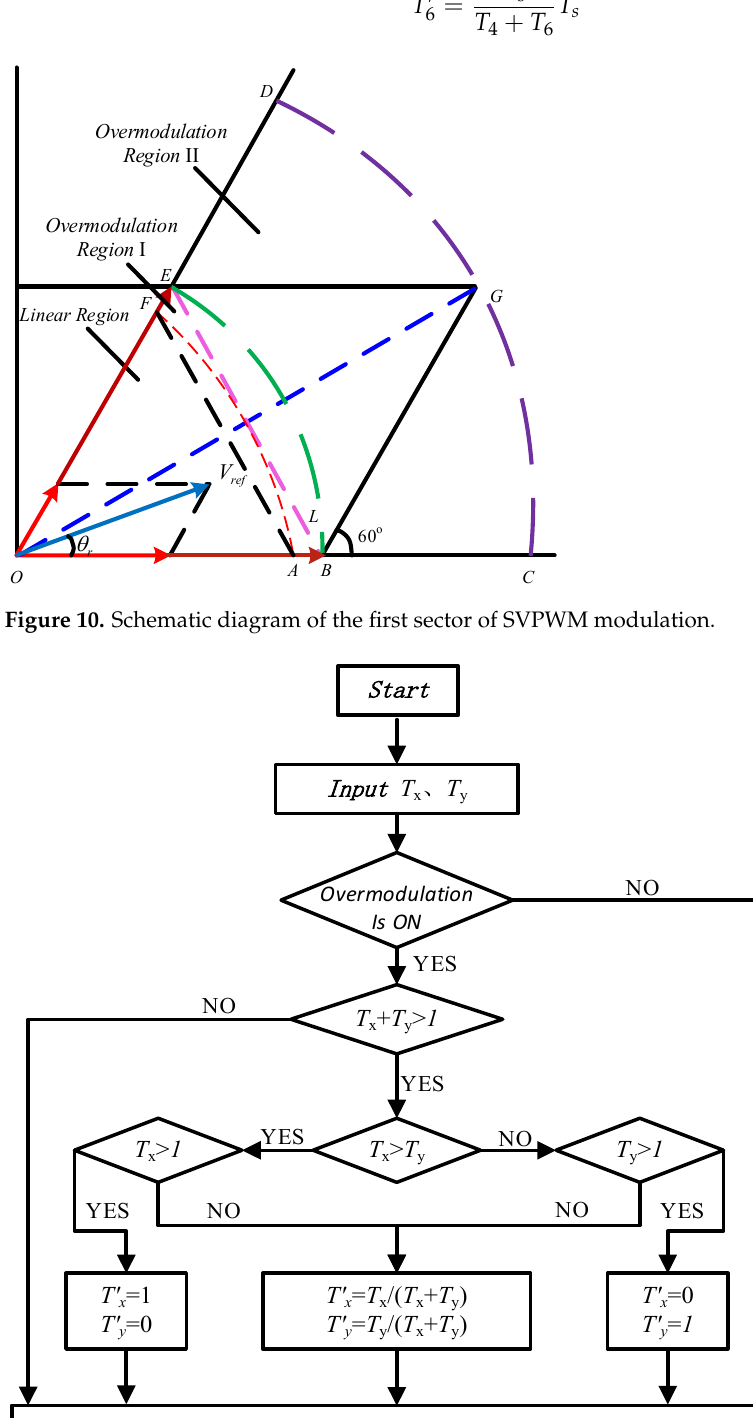
Figure 11. Flow chart of overmodulation algorithm.